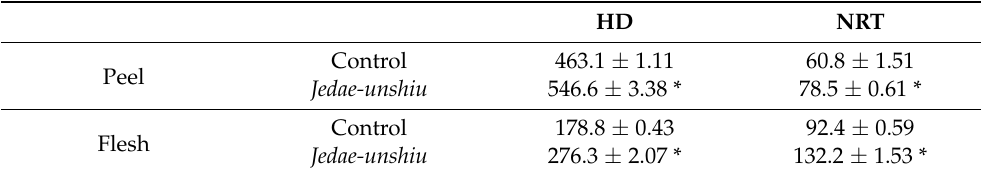
Table 3. Flavonoid contents of fruit peel and flesh (mg per 100 g of dry weight) harvested in